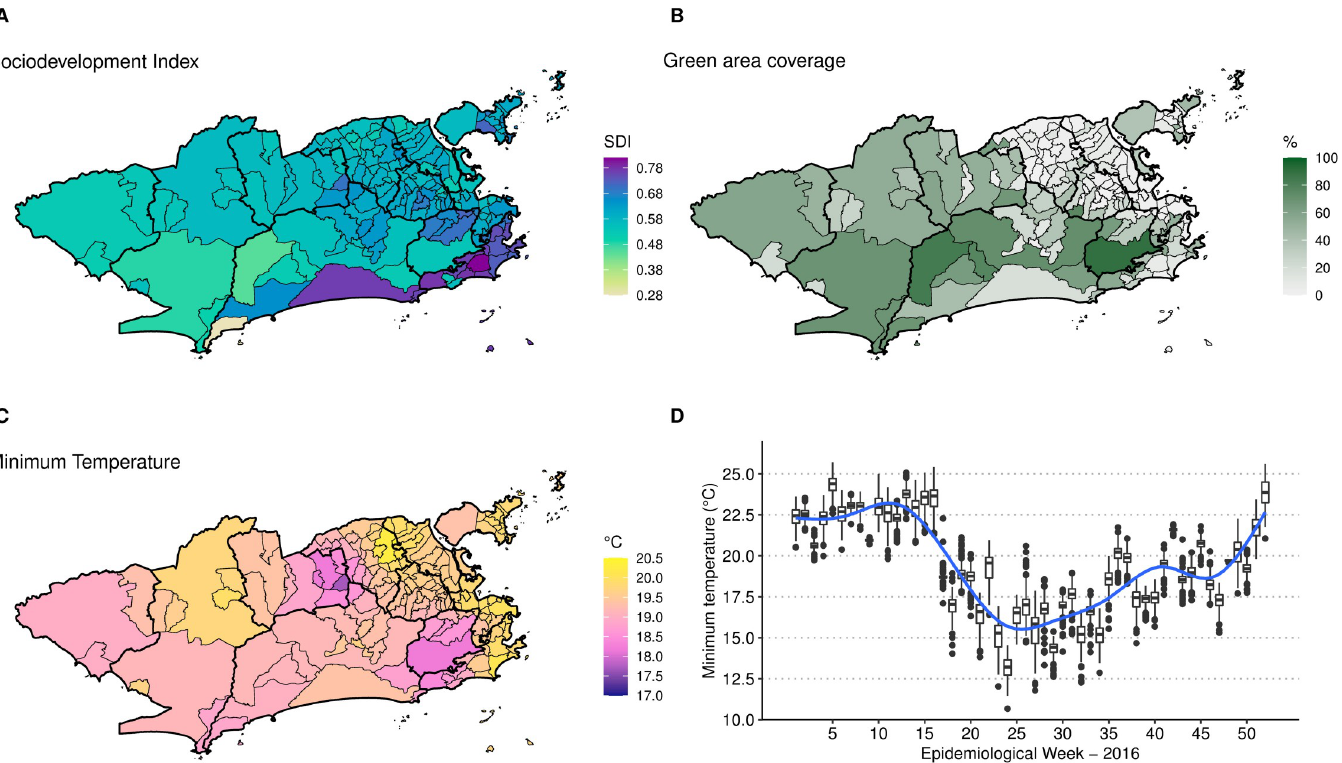
Fig 4. Sociodevelopment index in 2010 (A), percentage of green areas in 2015 (B), minimum temperature (˚C) average in 2016 by neighbourhood (C) and boxplot of the minimum temperature (˚C) by neighbourhood and week (D), Rio de Janeiro city, Brazil. Maps created using R version 3.6.1. Map layers by Instituto Pereira Passos